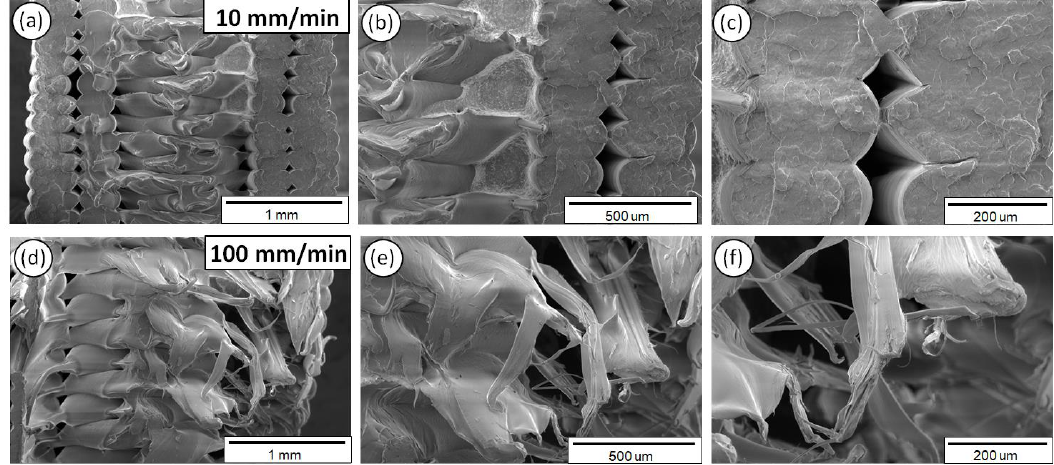
Figure 12. SEM images of PP fractured surfaces at three different magnifications for the 10 ( a,b,c ) and 100 mm/min ( d,e,f ) strain